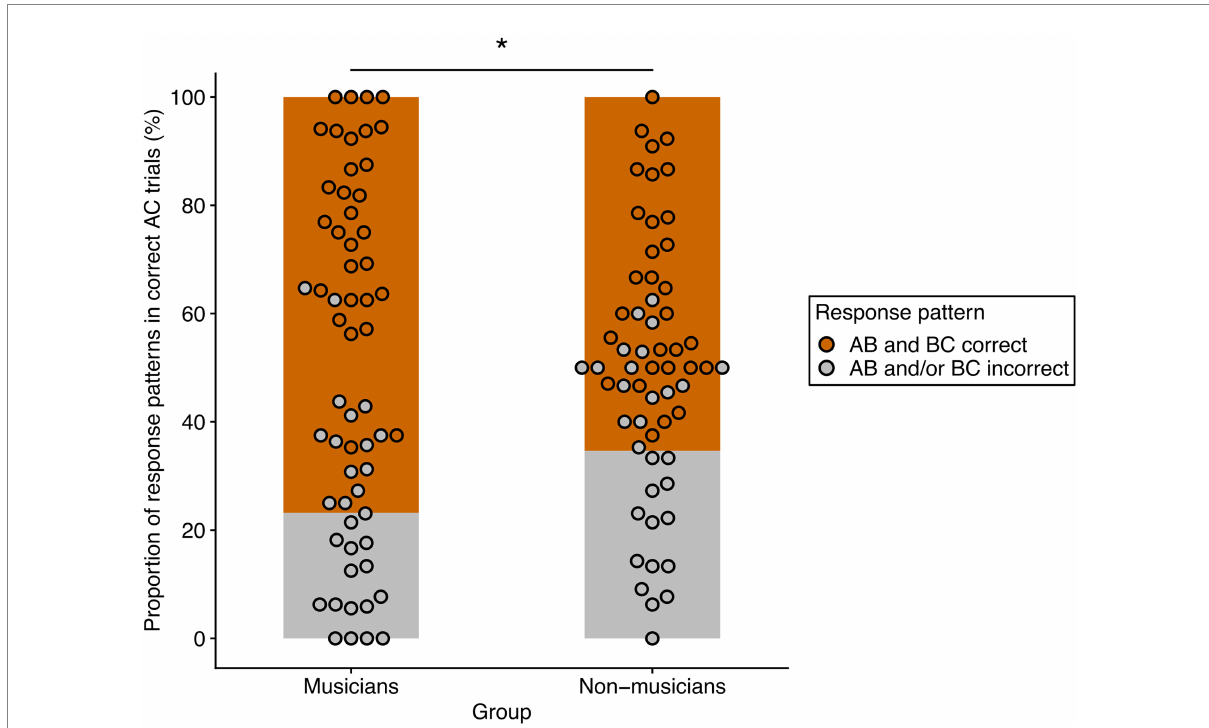
FIGURE 4 Relative frequencies of the two response patterns in musicians and non-musicians. AB and BC correct (orange) refers to the relative percentage of correctly answered AC-trials in which the corresponding AB-and BC-trials of the same overlapping ABC-triplet were also correctly answered. AB and/or BC incorrect (gray) refers to the relative percentage of correctly answered AC-trials in which the corresponding AB-or BC-or both trials of the same overlapping ABC-triplet were incorrectly answered. There was a significant effect of response patterns and a significant interaction of response pattern and group. The asterisk denotes the significant pairwise comparison of response patterns between groups (* p < 0.05 after Bonferroni-Holm